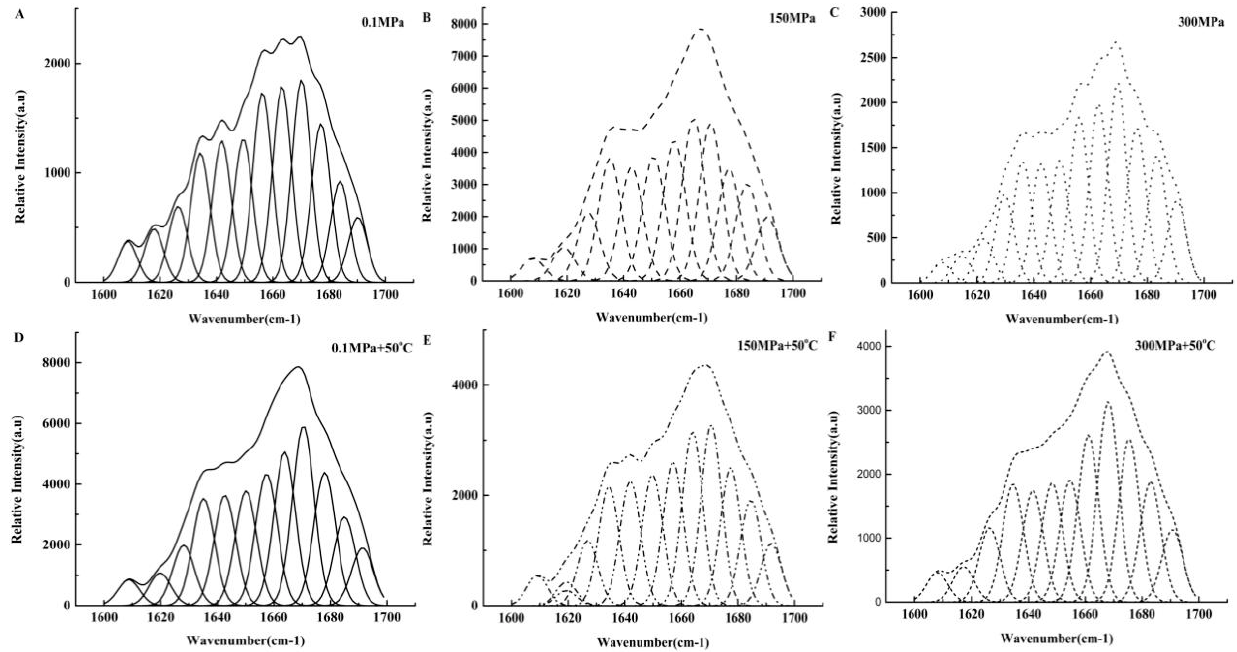
Figure 3. The effect of different treatment conditions (0.1 MPa, 150 MPa, 300 MPa, 0.1 MPa + 50 ◦ C, 150 MPa + 50 ◦ C, 300 MPa + 50 ◦ C) on the Raman spectra of collagen. Table 1. The effect of different treatment conditions (0.1 MPa, 150 MPa, 300 MPa, 0.1 MPa + 50 °C, 150 MPa + 50 °C, 300 MPa + 50 °C) on the secondary structure of collagen. Different Treatment Conditions